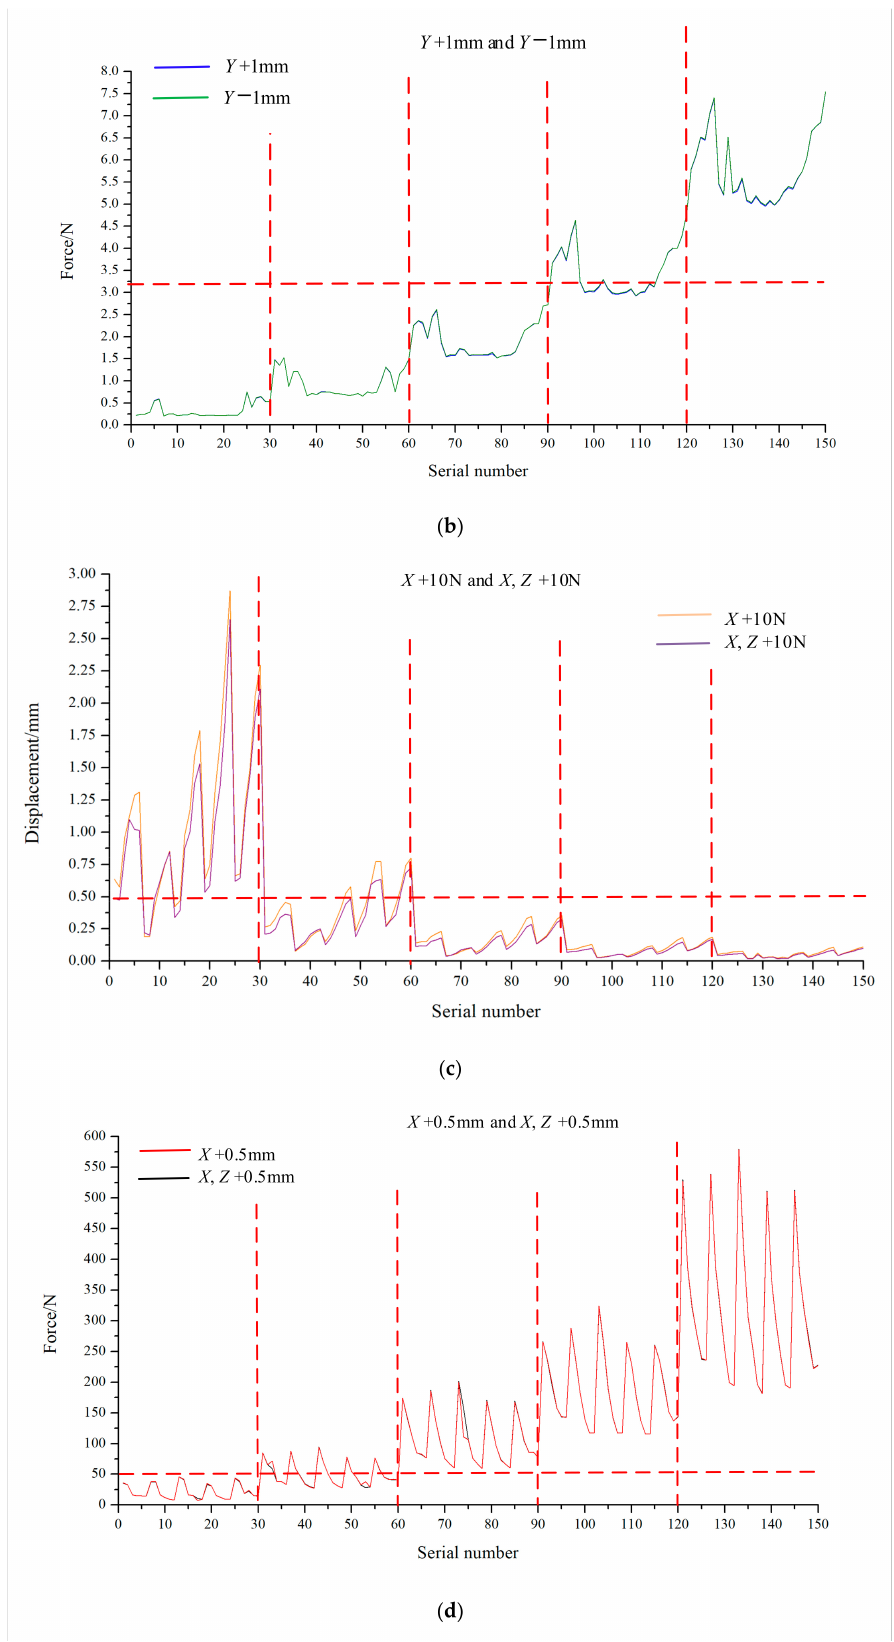
Figure 6. The data analysis of BBR. ( a ) Y + 1 N and Y − 1 N. ( b ) Y + 1 mm and Y − 1 mm. ( c ) X + 10 N and X , Z + 10 N. ( d ) X + 0.5 mm and X , Z + 0.5